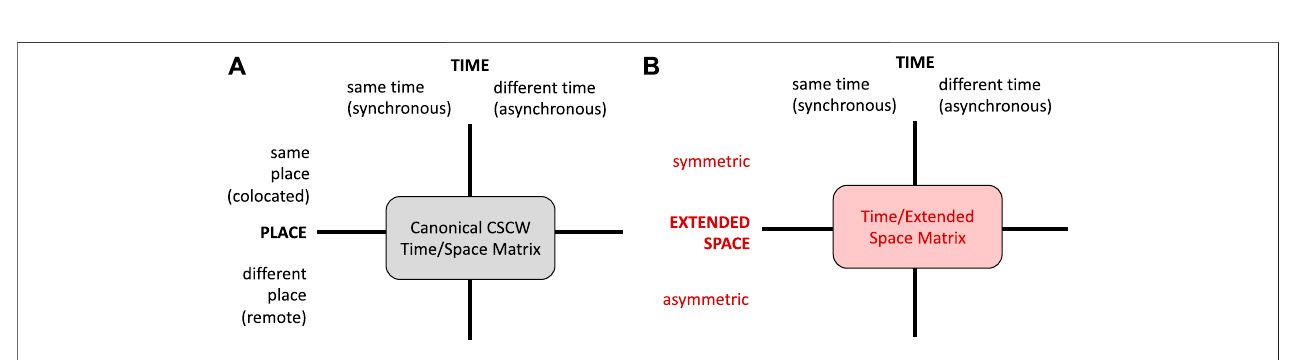
FIGURE 2 | (A) Canonical CSCW Matrix and (B) our matrix for extended collaborative spaces in Mixed Reality environments.